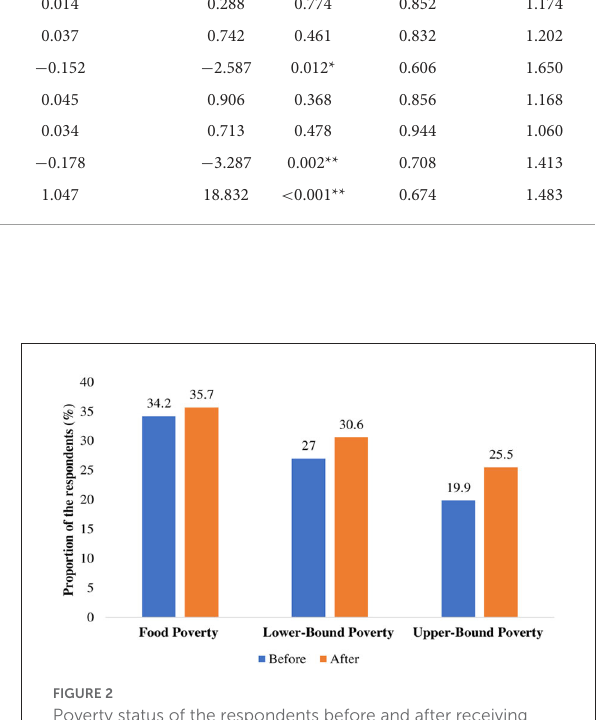
comparisons for FPL, LBPL and UBPL are presented in Table